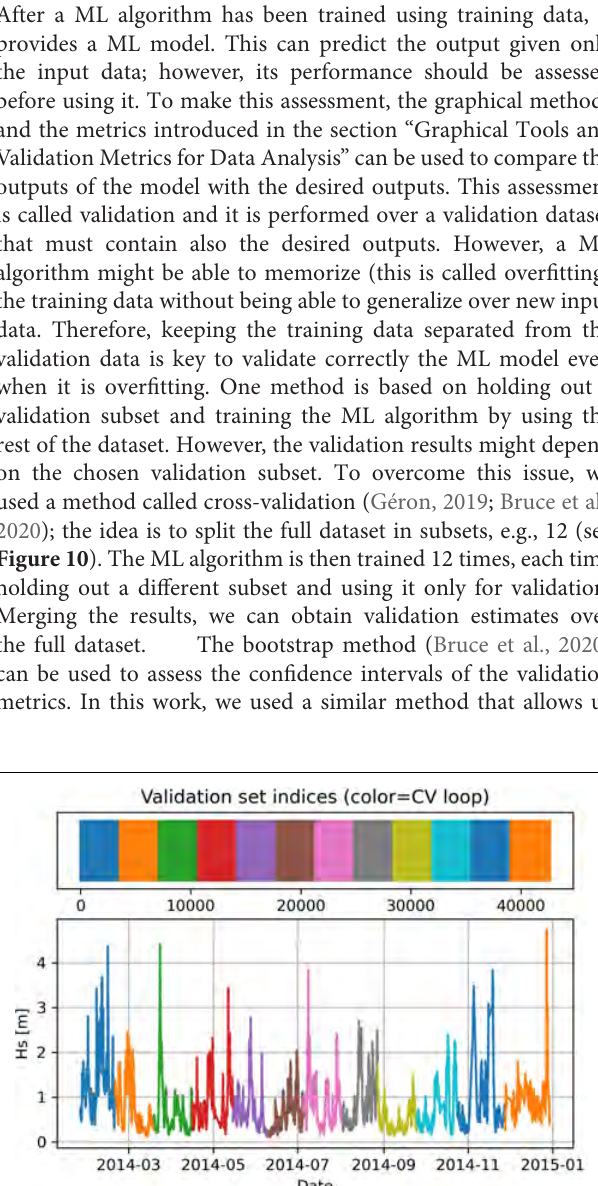
FIGURE 11 | Validation metrics (RMSE and correlation) of the Random Forest ML model (20 predictors) computed over 50 different time spans. (A–C) labels are referred to Hs, Tm, and Tp, respectively. 1 and 3 are the time plots of RMSE and correlation respectively, whereas 2 and 4 are their ECDF